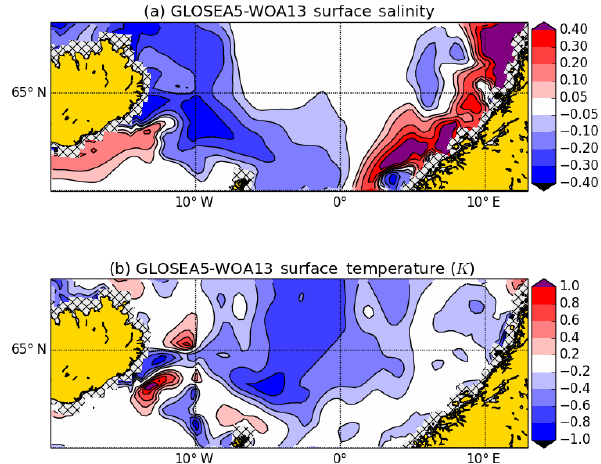
Figure 17. GLOSEA5 minus WOA13. Panel (a) is mean surface salinity. Panel (b) is the mean surface